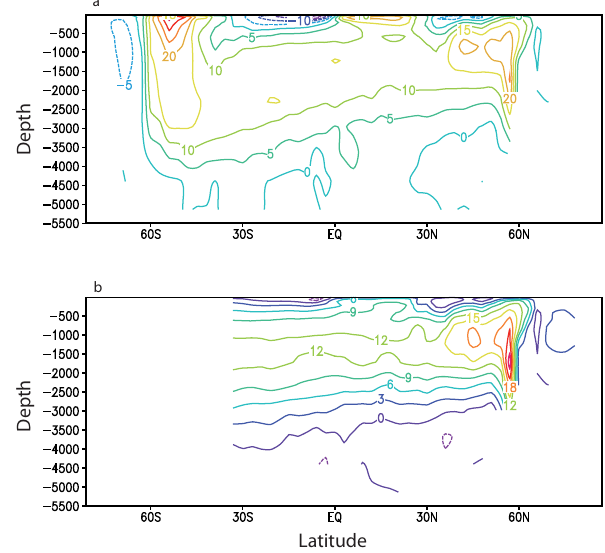
Fig. 22. Simulated meridional overturning streamfunction (in Sv) for (a) the whole World Ocean and (b) the Atlantic simulated for the Last Glacial Maximum.